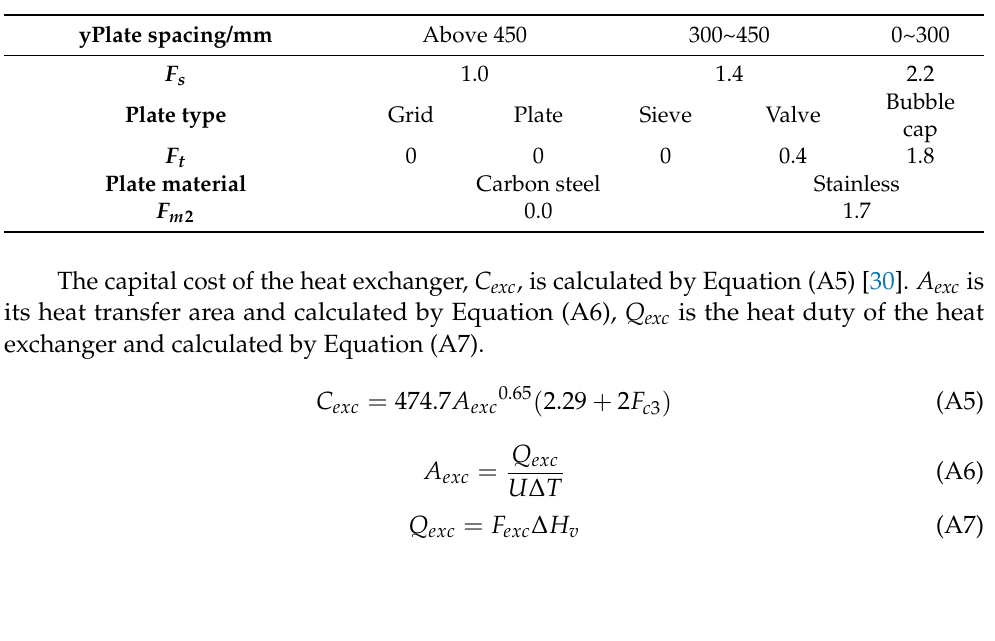
Table A2. Correction factors for column